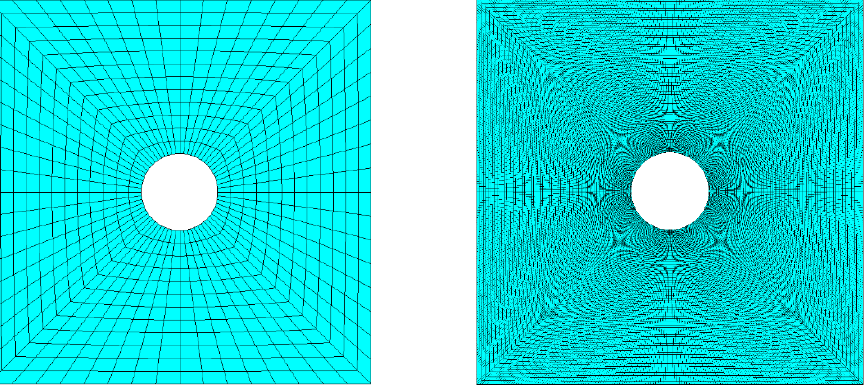
Figure 5. The central square of the plate featuring the coarsest ( left ) and finest ( right ) levels of discretization on the unbiased